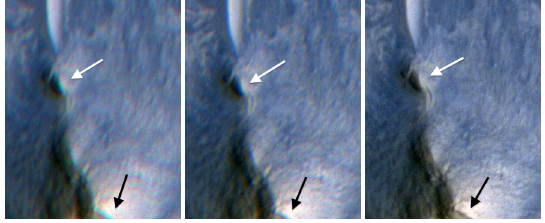
Figure 7. Comparison of the mean and standard deviation (left) of the jitter magnitude (pixels) before and after correction. Best correction points lie below the 1:1 red diagonal line. For the mean and standard deviation tests, there is improvement for all cases where the jitter magnitude is > 0 . 5 pixels. The max magnitude is not as effective of a measure of the correction due to outliers that do not get filtered out of the measurement routine.